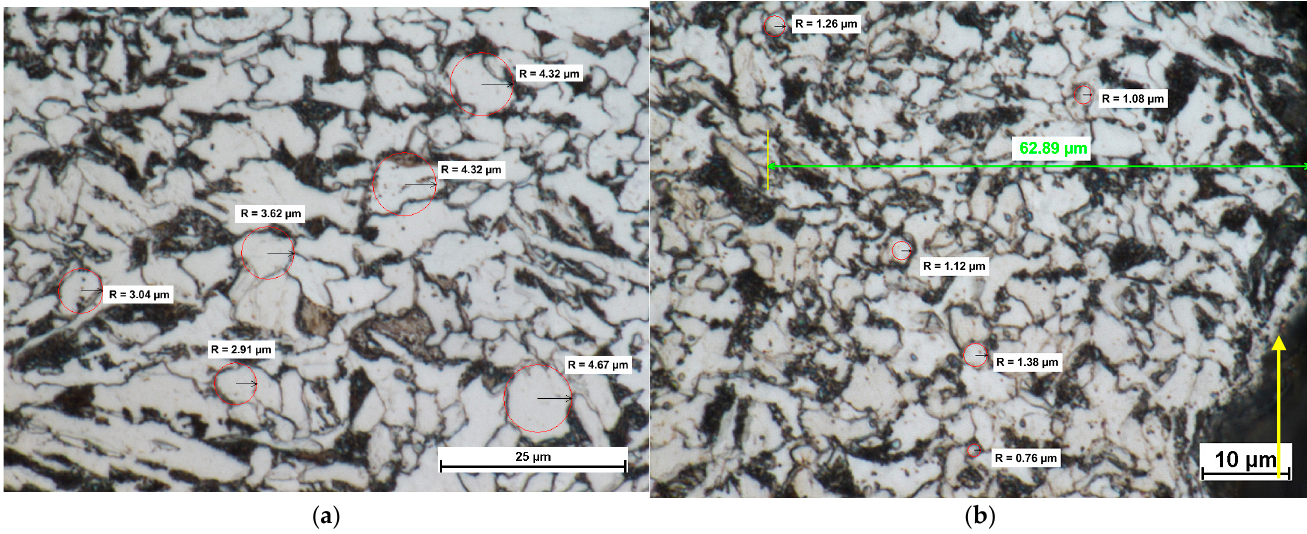
Figure 8. Metallographic microstructure of the cross-sectional area of cut ( a ) at a depth of about 3 mm from the upper cutting edge, ( b ) the cutting edge (a pressure of 380 MPa and a cutting speed of 250 mm/min).